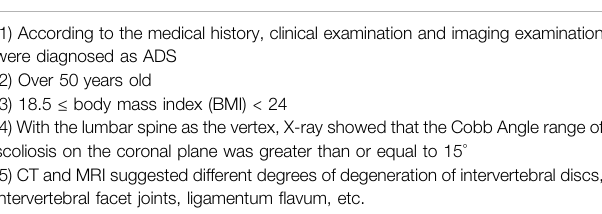
TABLE 1 | Inclusion criteria of the ADS group. Inclusion criteria of the ADS group